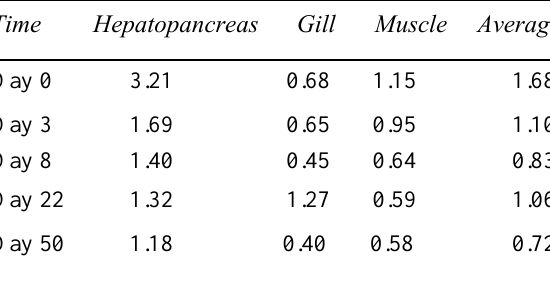
Table 4: Tissue arsenic concentrations from final bioconcentration day to final depuration day, 3.42